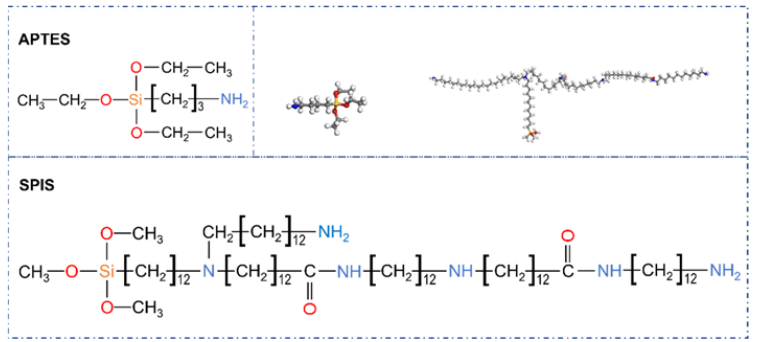
Figure 1. Chemical structures of APTES and SPIS.